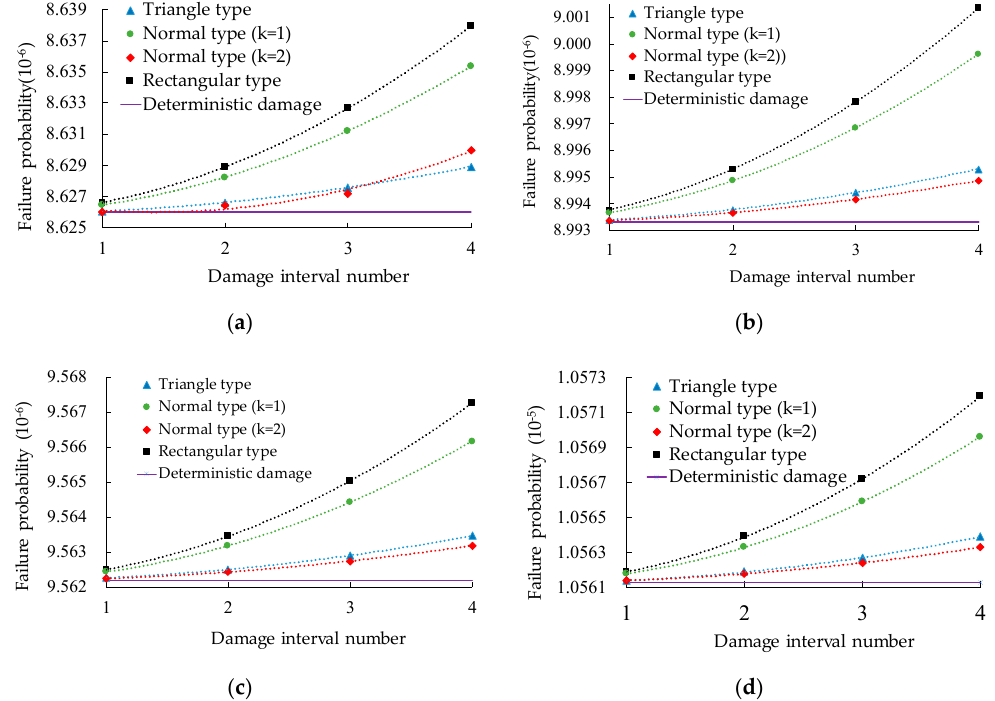
Figure 3. Failure probability of 1# slab in different hinge joint damage intervals under different membership functions. (The maximum credibility is 0.2): ( a ) Hinge joint damage case 1; ( b ) hinge joint damage case 2; ( c ) hinge joint damage case 3; ( d ) hinge joint damage case 4.